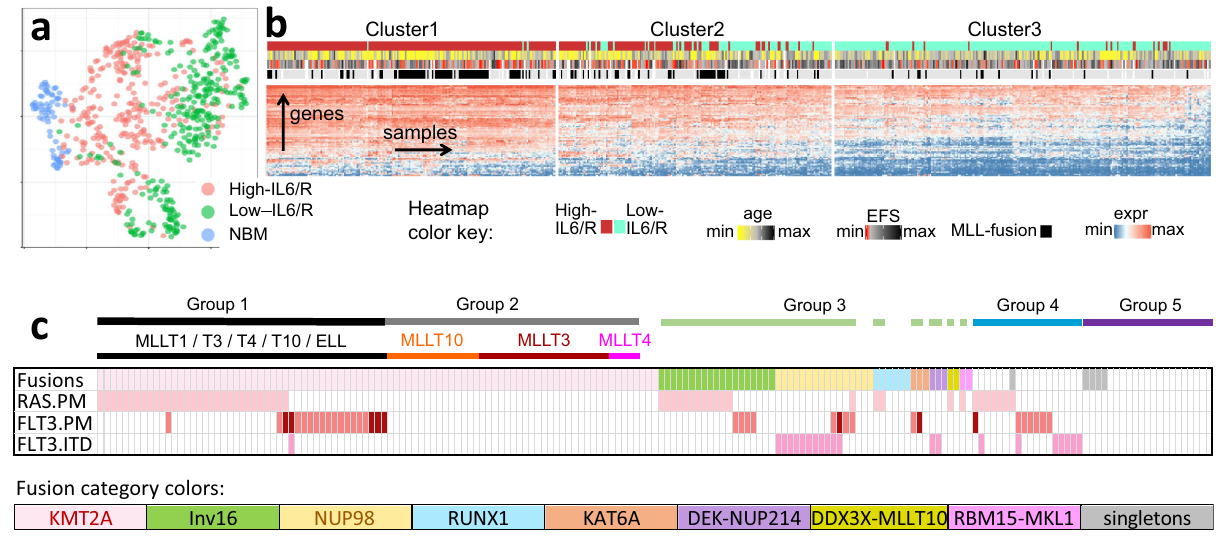
Fig. 3 | High-IL6/R pAML BM samples are highly distinct in terms of their immunological, transcriptional, and genomic characteristics. a In a UMAP projection using 1,506 immune genes, 287 high-IL6/R pAML, 306 low-IL6/R pAML and 45 NBM samples form distinct clusters, indicating broad immune differences. b Unsupervised hierarchical clustering of the expression levels (log2(TPM+1)) of 82immuneandcancergenesdivideshigh-andlow-IL6/Rsamples( n =287and306 respectively)into3groupswithsharplydistinctratesof MLL genefusions,response totherapy(5-yearEFS),andageatdiagnosis.Theminimumlog2expressionvalueis zero and the maximum is 11.08. The minimum age is 18 days and the maximum is 26.85 years. The minimum EFS is1 day, and the maximum is 8.2 years. c Oncoprint summarizing the distribution of somatic DNA alterations in 181 high-IL6/R